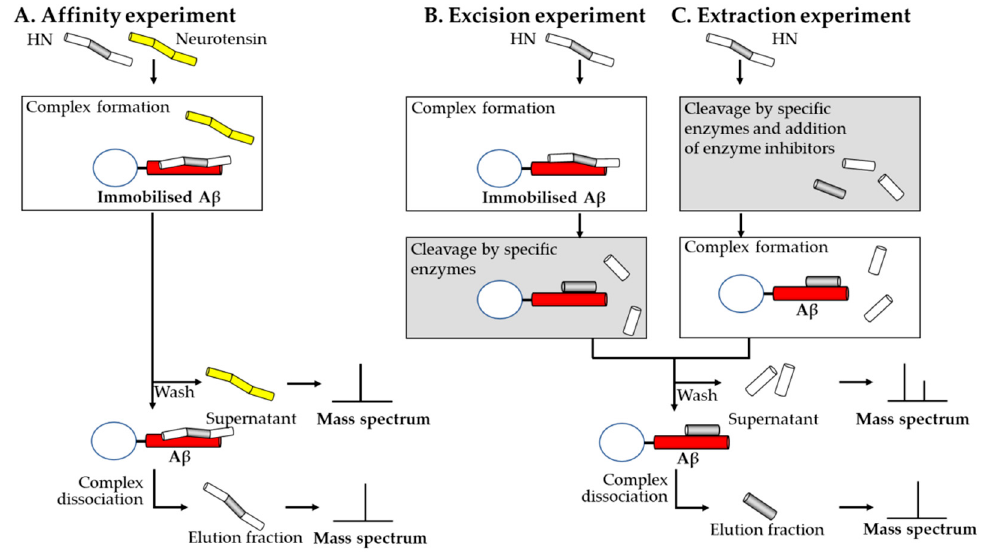
Figure 2. Schematic representation of the affinity mass spectrometric experiments carried out for the identification of the binding sequences of two peptides forming a complex using one immobilized binding partner. ( A ) Scheme of an affinity experiment using immobilized A β peptide. A mixture of humanin and neurotensin is incubated with the affinity medium. The mass spectrum of the supernatant should contain non-binding peptides and the mass spectrum of the elution fraction should contain the peptides presenting affinity towards amyloid-beta peptide. ( B ) In the excision experiment, intact humanin is incubated with immobilized A β followed by proteolytic cleavage of the peptide fragments that are not protected against proteolysis through the interaction. Mass spectrum of the supernatant reveals the regions from humanin which do not interact with A β while the mass spectrum of the elution fraction shows the region which is involved in the interaction. ( C ) In the extraction experiment humanin is first proteolitically cleaved, then protease inhibitors are added and the mixture is incubated with immobilized A β . The mass spectra of the supernatant and elution fractions obtained from both the excision and extraction experiments indicate the binding region of humanin.